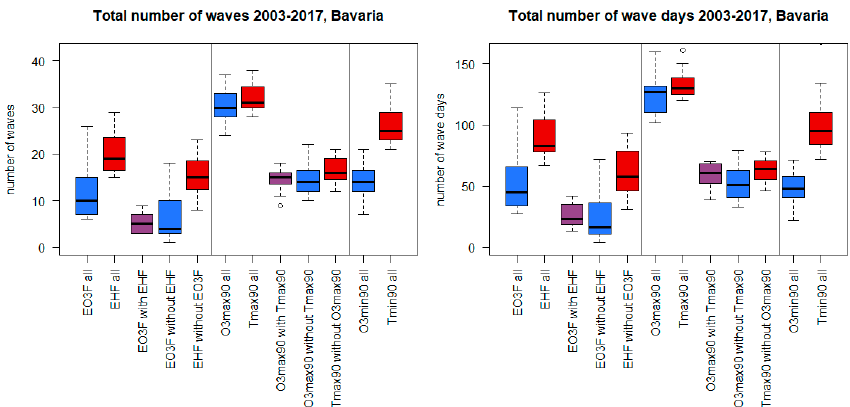
Figure 2. The total number of waves (left) and the total number of wave days (right) across the 15 stations of Bavaria in the period 2003–2017. EO3F all (EHF all): All ozone (heat) waves according to the EO3F (EHF) definition, EO3F with EHF: Compound ozone-heat waves, EO3F (EHF) without EHF (EO3F): Single ozone (heat) waves without heat (ozone) wave conditions, O3max90 all (Tmax90 all): All ozone (heat) waves according to the O3max90 (Tmax90) definition, O3max90 with Tmax90: waveswithoutheat(ozone)waveconditions, O3min90all(Tmin90all): Allozone(heat)wavesaccording to the O3min90 (Tmin90) definition. For ease of view, colors reflect the variables, i.e., blue: Ozone; red: Temperature; purple: Ozone and